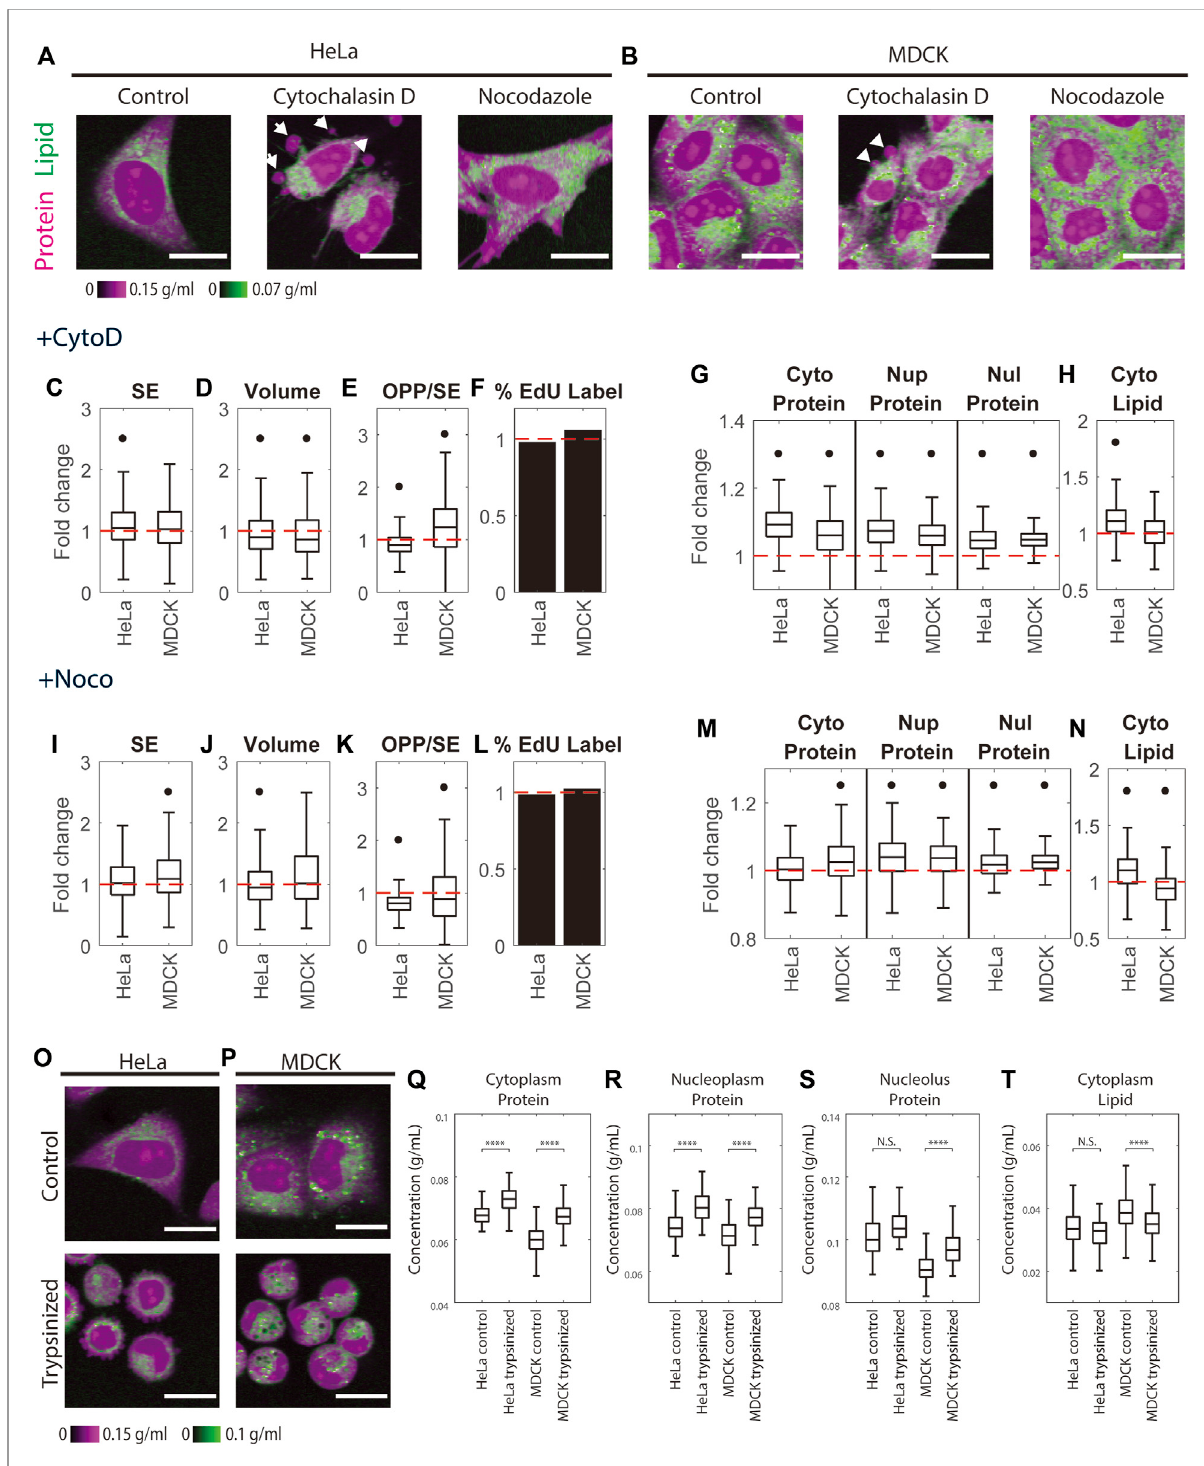
FIGURE 5 Cytoskeleton perturbation increases protein density. (A – B) Representative NoRI images of untreated HeLa and MDCK cells and cells treated with 5 µM Cytochalasin D or 5 µM Nocodazole for 1 h. White arrows indicate blebs. Scale bar, 20 µm. (C – F, I – L) Fold change of cell dry mass (SE) (C,I) , cell volume (D,J) , protein synthesis rate quanti fi ed by the pulse labeled OPP to SE protein stain ratio (OPP/SE) (E,K) , and DNA replication (percentage of EdU labeled cells) (F,L) in Cytochalasin D treated (+CytoD) or Nocodazole treated (+Noco) cells normalized to the median of untreated cells. (G – H, M – N) Fold change of protein densities and cytoplasmic lipid density in Cytochalasin D treated (G – H) or Nocodazole treated